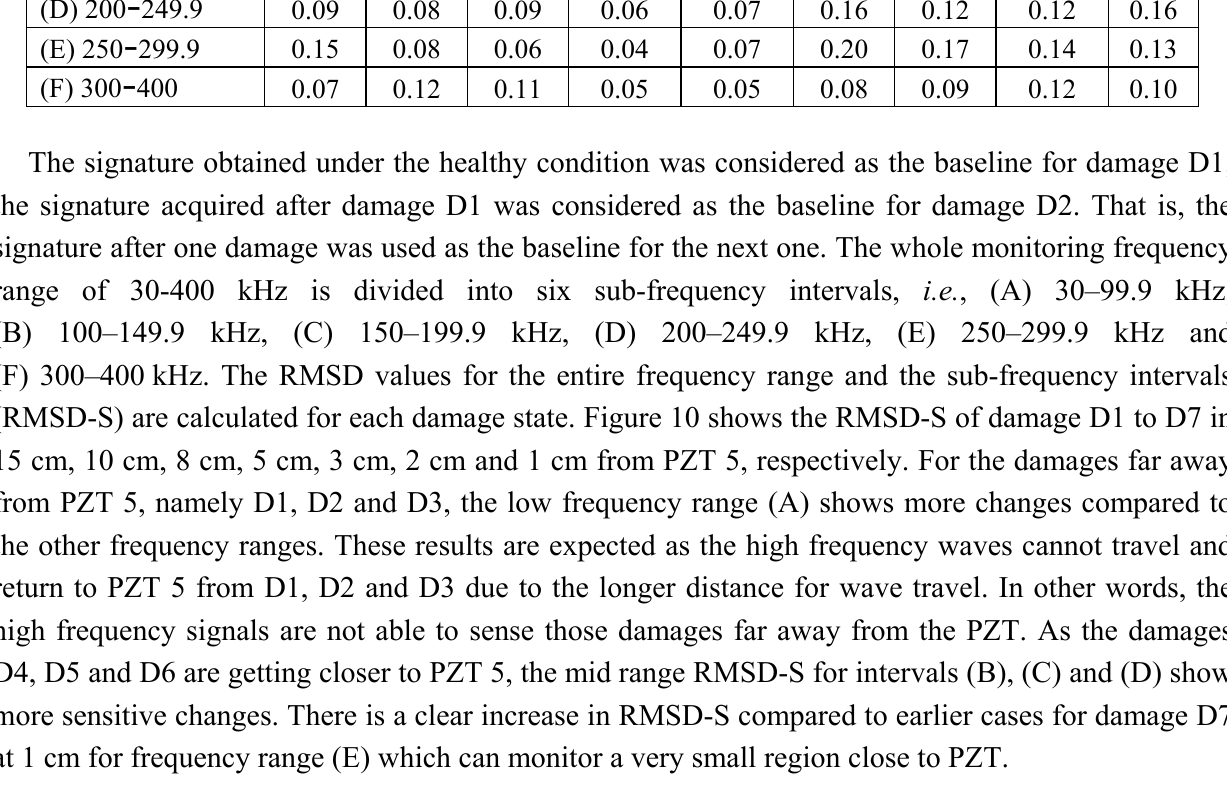
Figure 10. RMSD-S of damage D1 to D7 for PZT